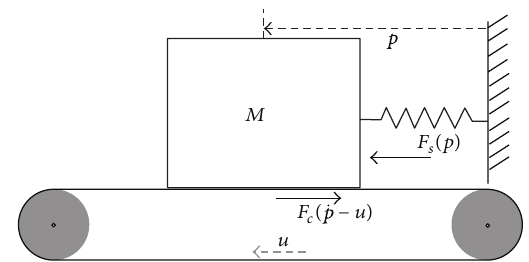
Figure 10: Example III: periodic motion. In the simulation, the parameters were chosen as 𝐹 = 0.2 N, 𝑀 = 1 kg, 𝑘 1 = 1 N/m, = 1 N / m 3 , 𝑢 = 1 m/s, and 𝑉 = 1 m/s, and the initial conditions 𝑘 2 are 𝑝 = 1.19149 m, and 𝑤 = 0 m/s.